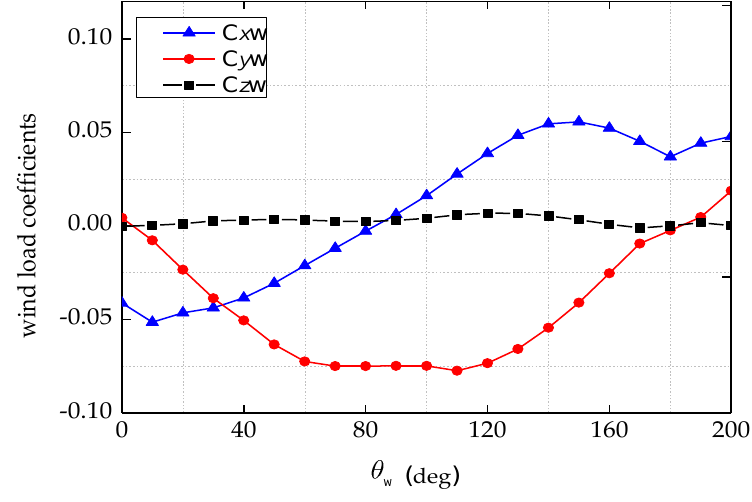
Figure 5. Wind load coefficients.